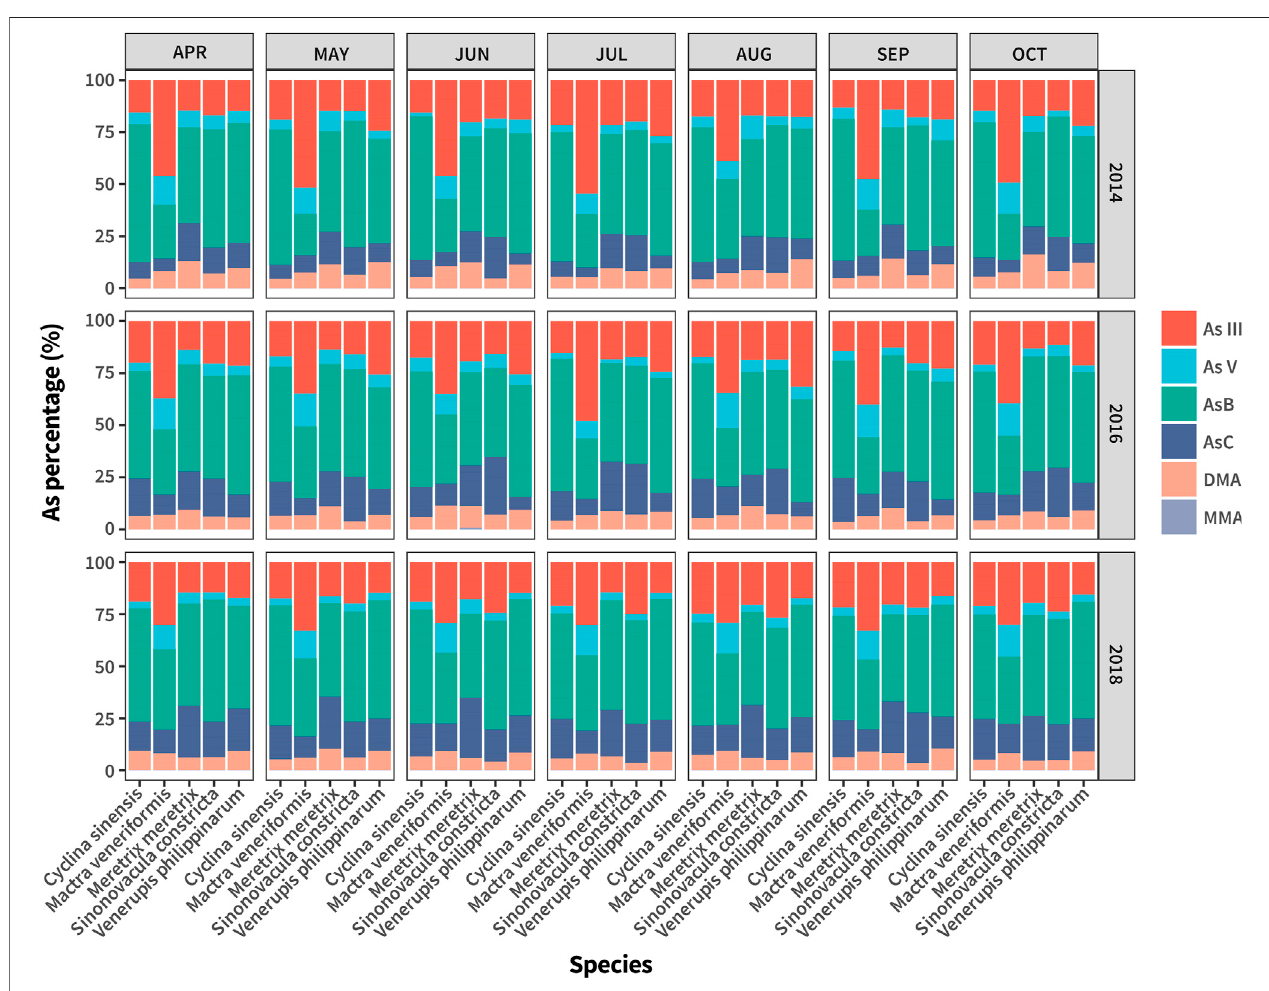
FIGURE 3 | Contribution of fi ve As species to total As in collected clam